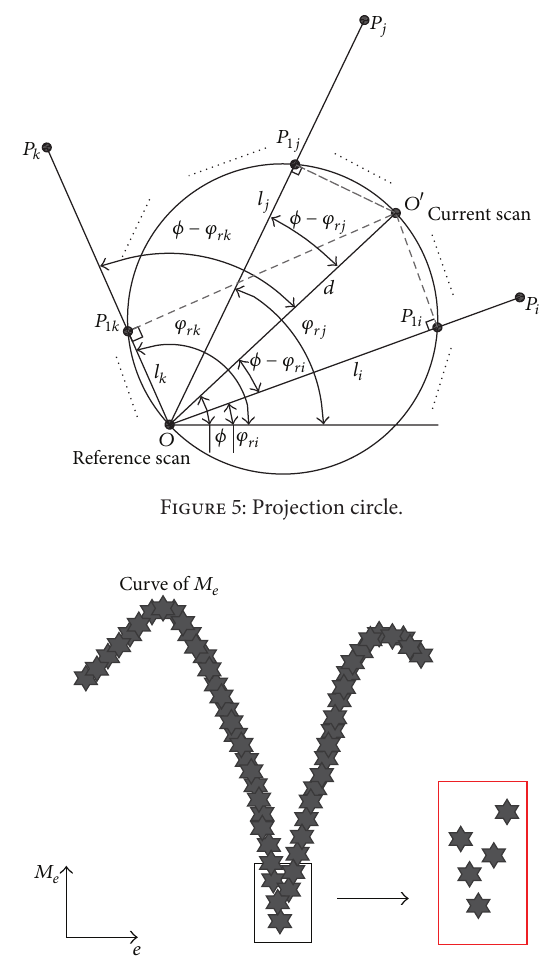
𝑀 𝑒 direction. However, due to the discreteness error 𝑒 in of 𝑀 𝑒 , the rotation estimation further needs to be corrected based on one kind of linear absolute